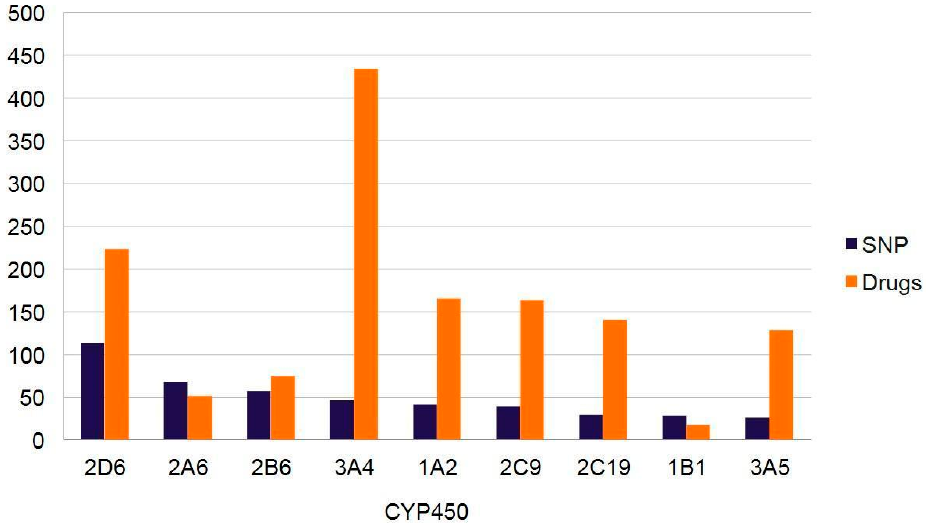
Figure 1. Number of known single nucleotide polymorphisms (SNPs) and drugs metabolized per cytochrome P450 (CYP) enzymes (modified from Preissner et al., 2013 [ 98] ).